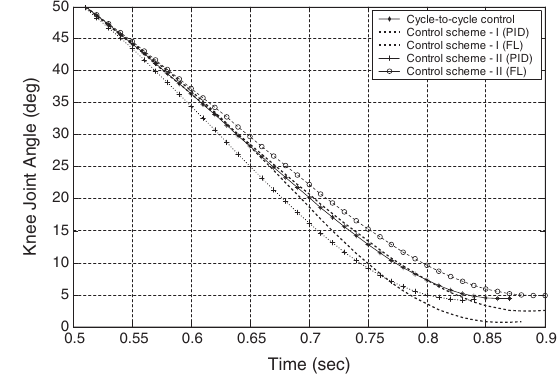
Fig. 18. Time-integral of the controller output u ( t ) modulating PW stim for the control approaches considered in this study.